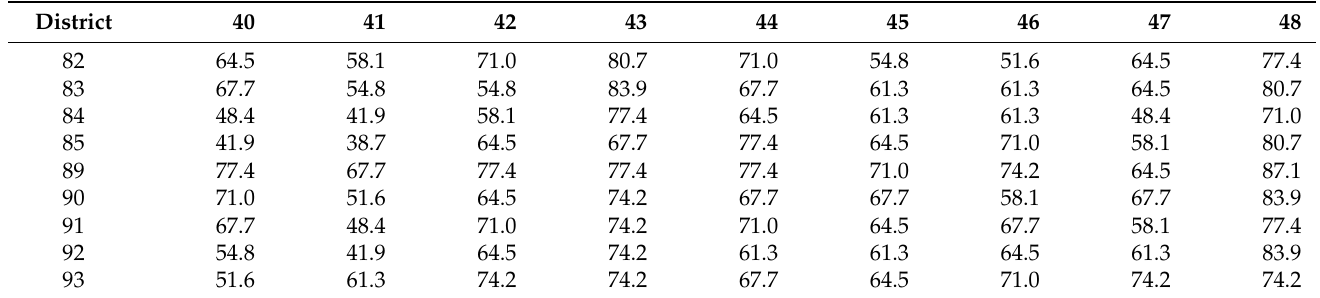
Table 2. Initial dry-spell probability (%) of SAWS rainfall districts during the mid-January-to-end-of- February period (pentads 40 to 48) from 1985 to 2015.